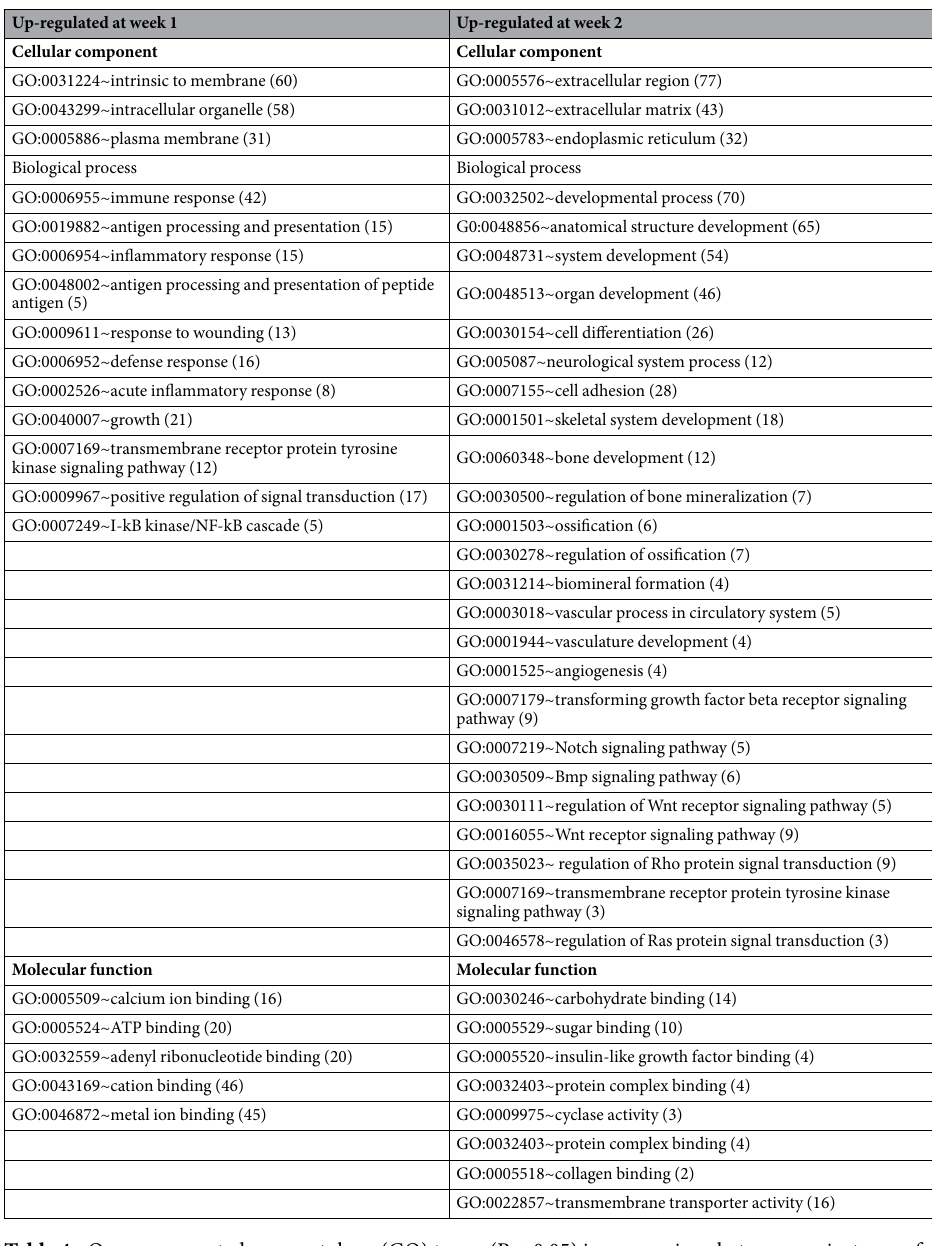
Table 4. Over-represented gene ontology (GO) terms (P < 0.05) in comparison between periosteum of defects site at week 2 and 1, with number of genes indicated in